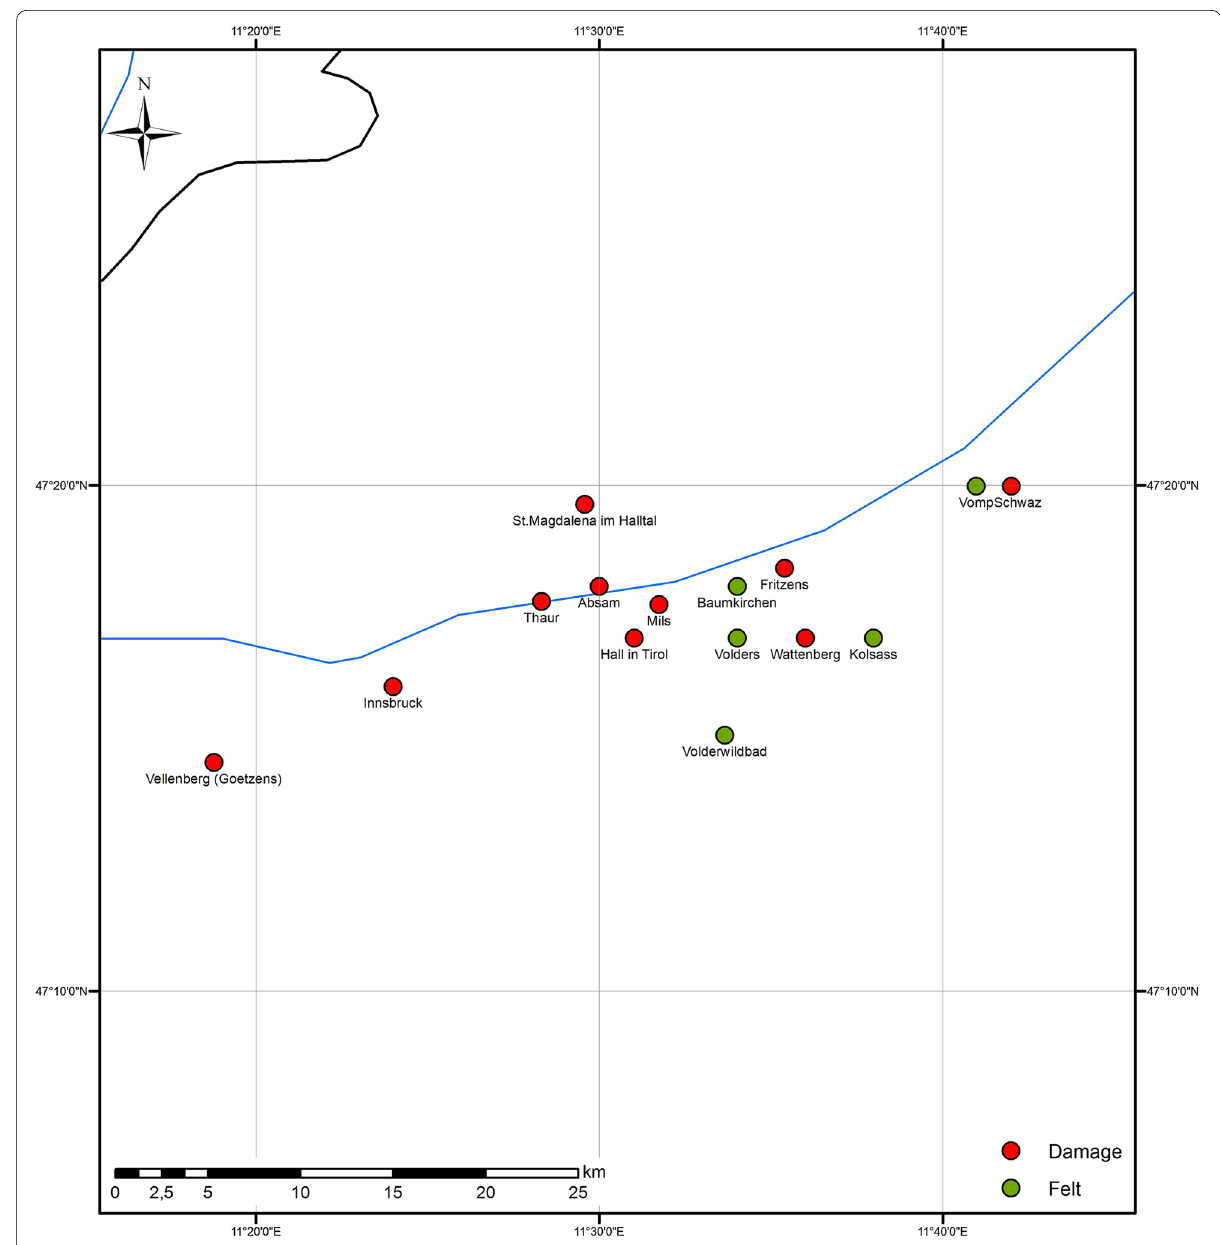
Fig. 6 Macroseismic map of the damage area of the 17th July 1670